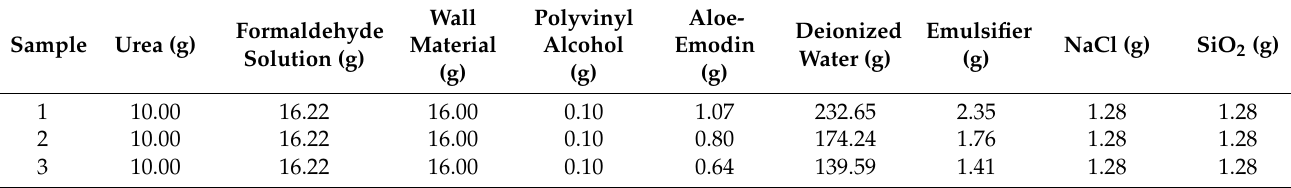
Table 4. Material list of the orthogonal